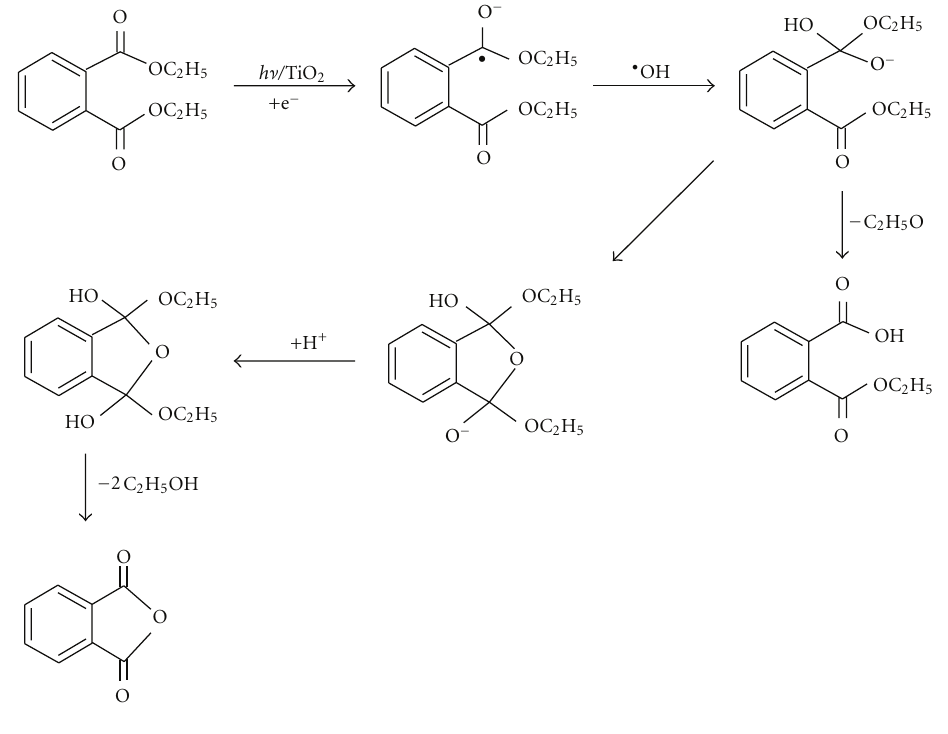
Figure 4: Photocatalytic degradation scheme for DEP